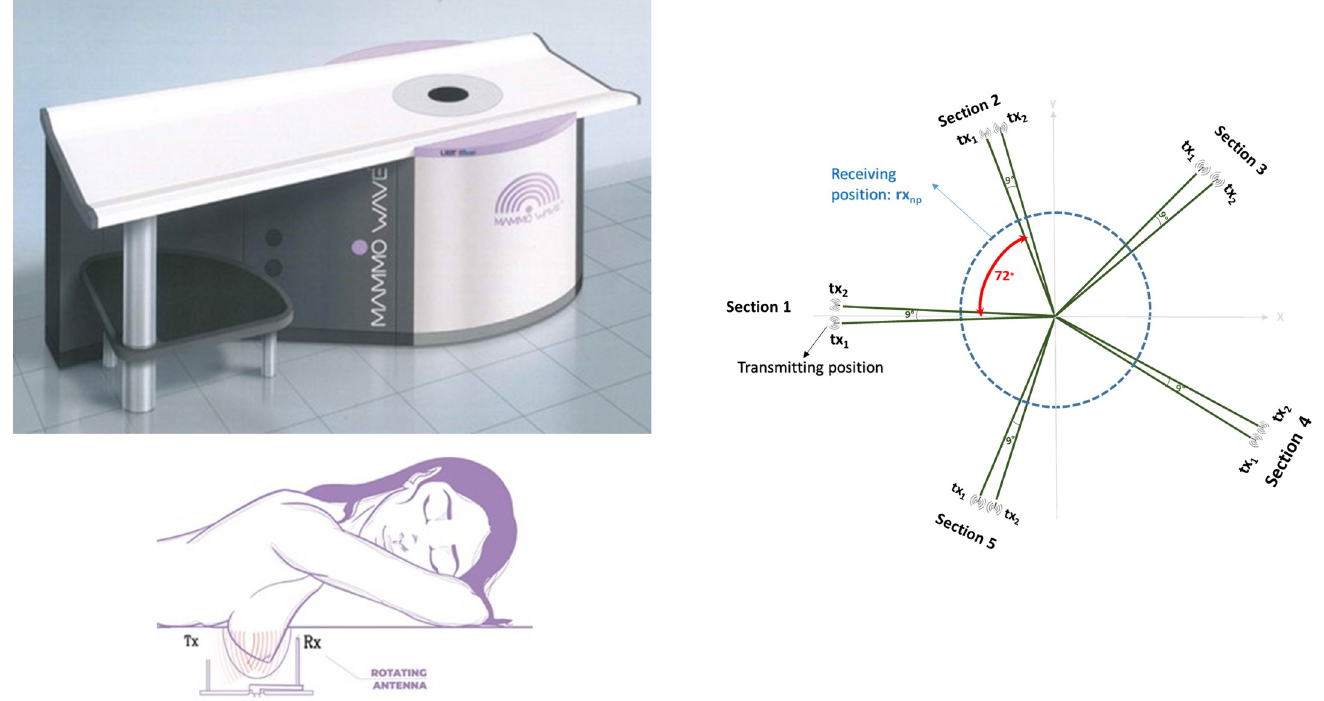
Fig 1. The MammoWave system (top left), consists of an aluminum cylindrical hub containing two antennas, one transmitting and one receiving antenna. The hub is equipped with a hole with a cup, allowing the insertion of the patient’s breast, with the patient lying in a prone position (bottom left). The antennas are installed at the same height, in free space and are able to rotate around the azimuth in order to collect the microwave signals from different angular positions (right).